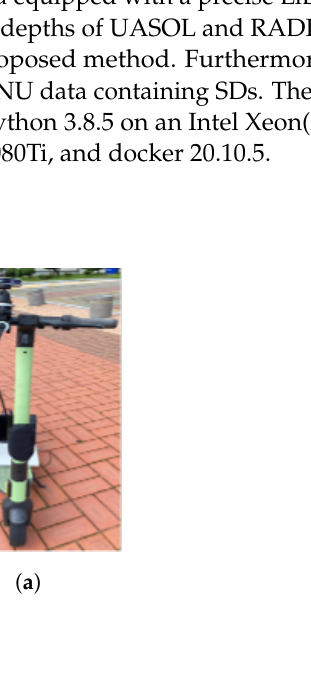
Figure 6. CNU datasetacquired using Intel RealSense D435. ( a ) Scooter, ( b ) a part of university map and path for collecting data(magenta line, S and E mean start and end point